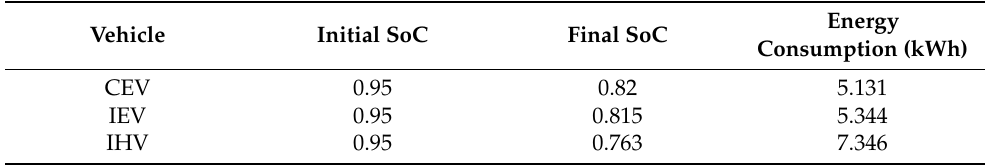
Table 4. Energy consumption and SoC comparison.